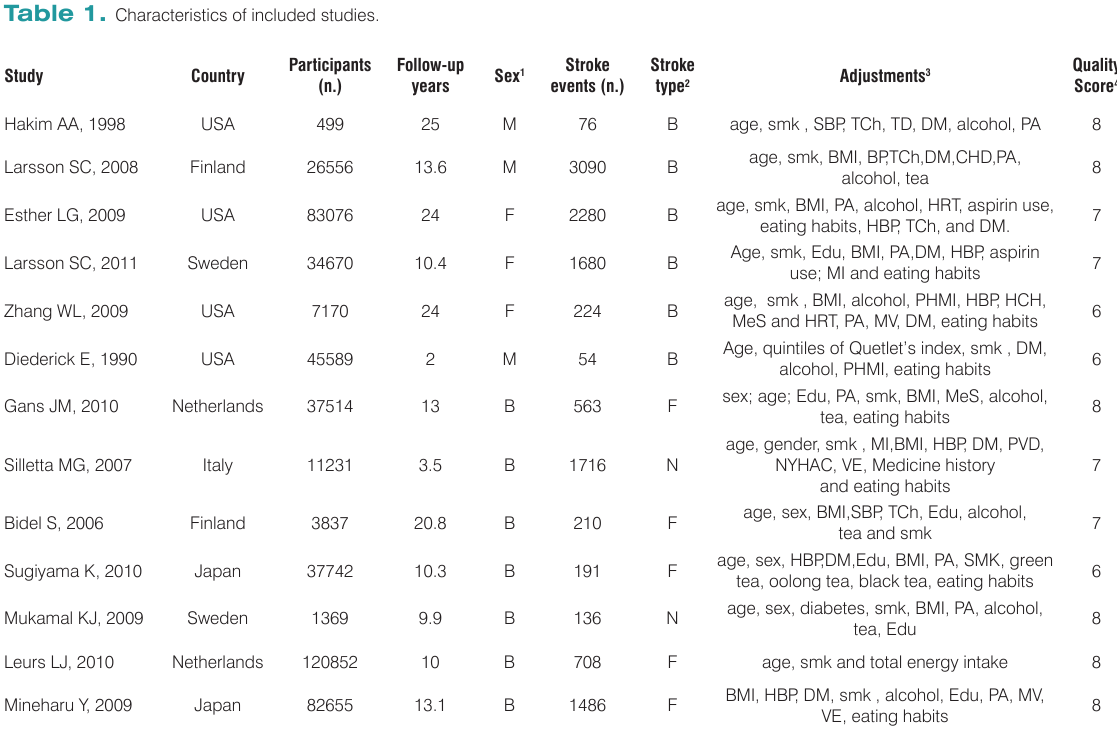
Table 1. Characteristics of included studies.